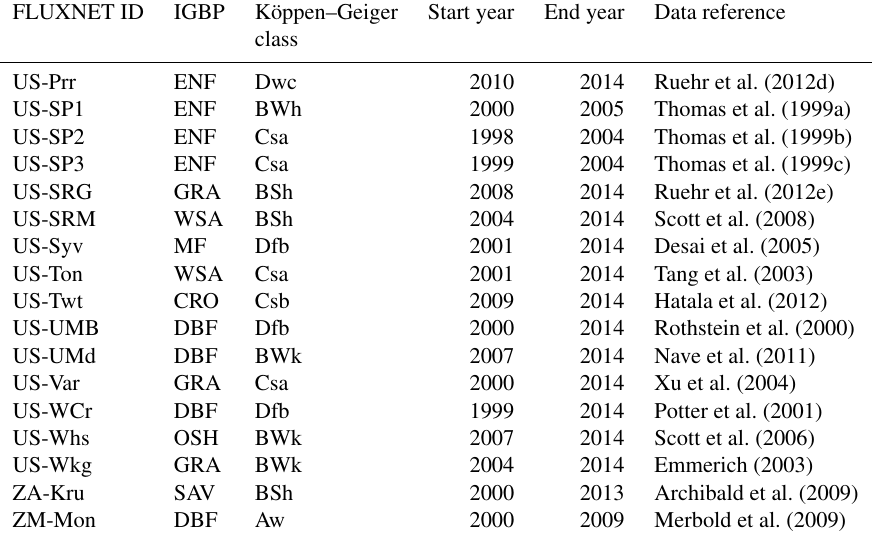
Table A1. Continued.